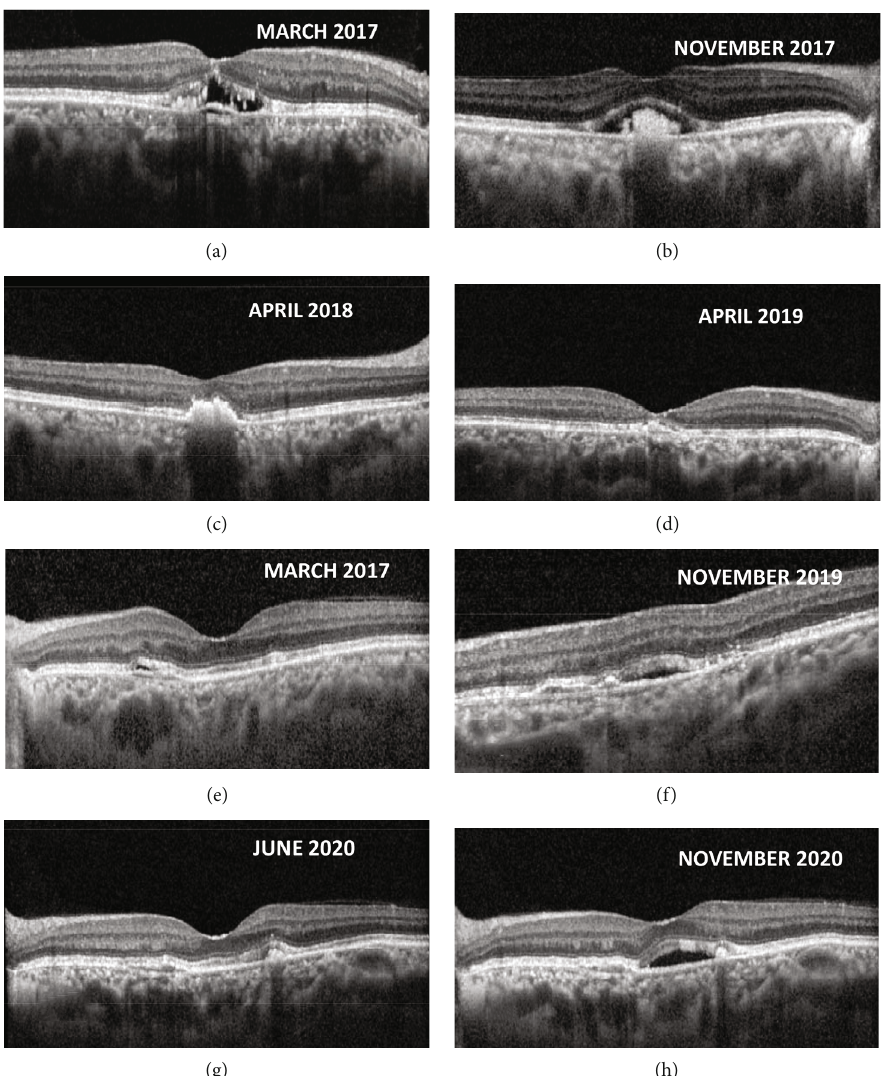
Figure 5: Serial spectral-domain optical coherence tomography (SD-OCT) images of right eye revealing fl attening of pigment epithelial detachment (PED) (a) and central clumping of vitelliform deposits (b) and later resorption ((c) and (d)) while the left eye revealed focal double-layer sign (DLS; (e)) and development of extrafoveal fl uid (f) managed conservatively and later new vitelliform deposition (g) followed by submacular fl uid (h) necessitating treatment. Note that these new hyperre fl ective lesions appear before the onset of exudation